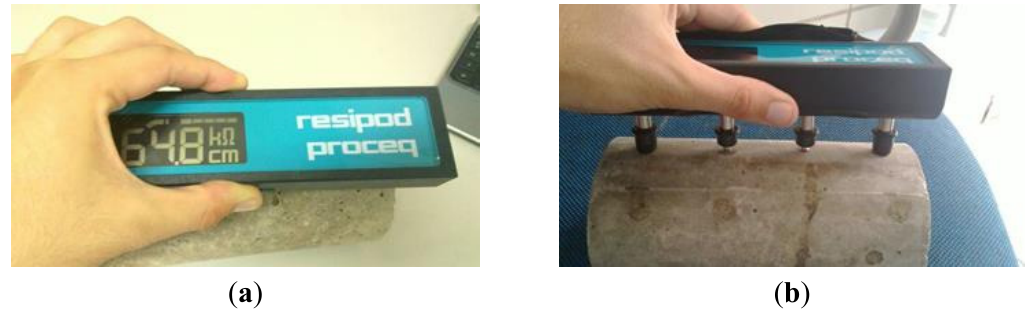
Figure 4. Visualization and measurement of the electrical resistivity. ( a ) electrical resistivity apparatus; ( b ) measuring electrical resistivity.